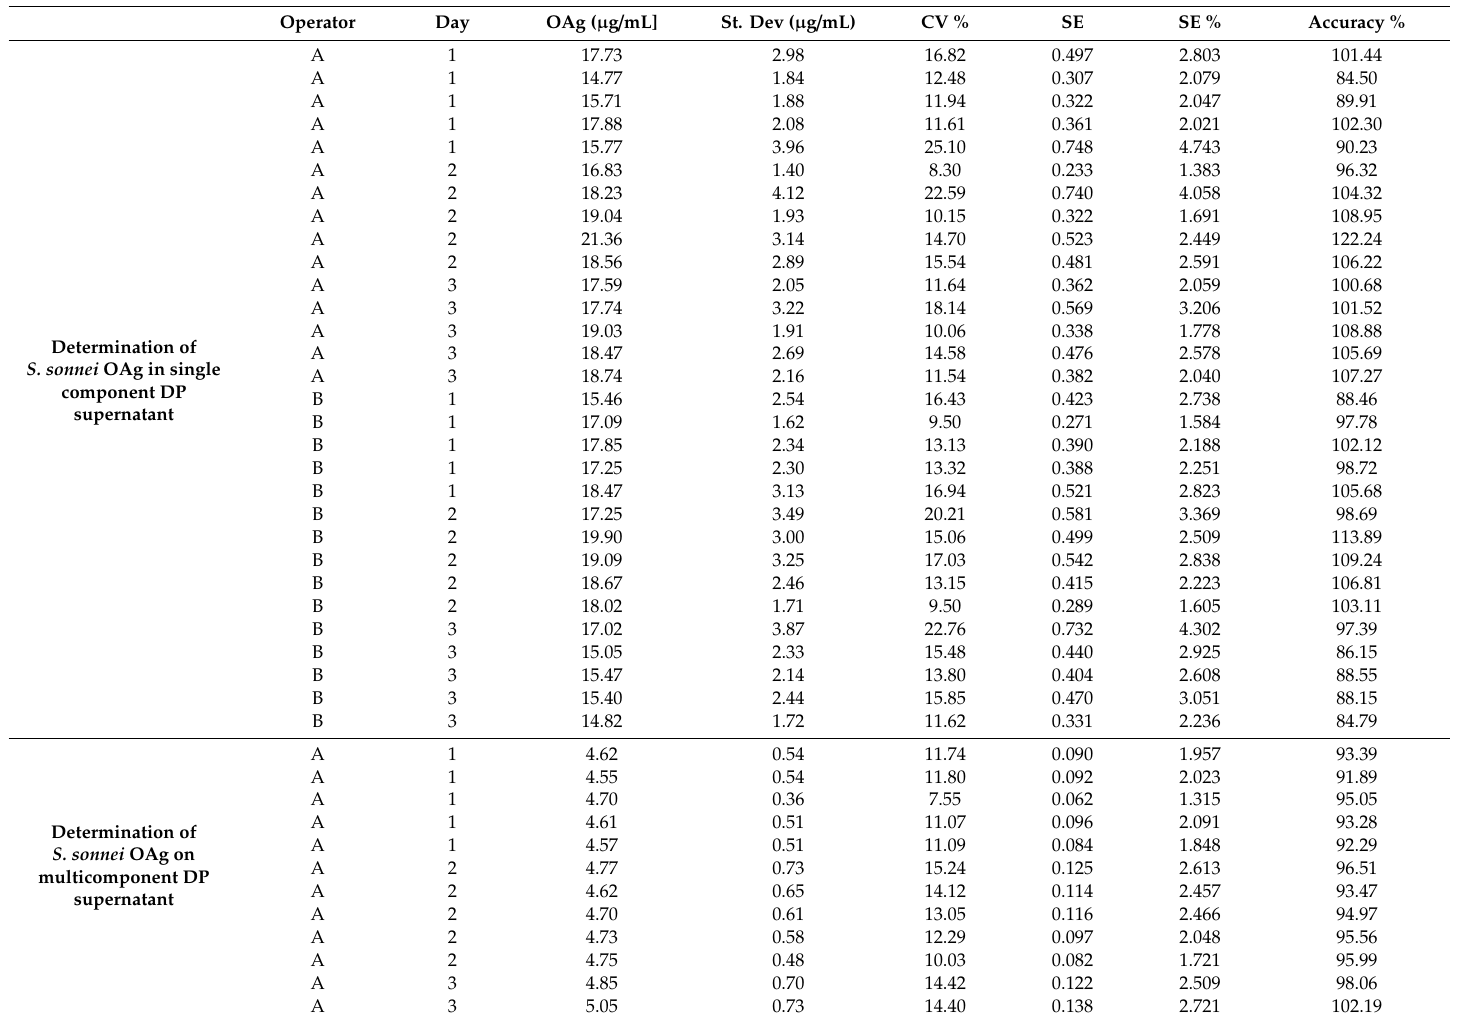
Table 3. FAcE assay results for each single test performed. n.d., not detectable; St. Dev, standard deviation; SE, standard error; CV, coe ffi cient of